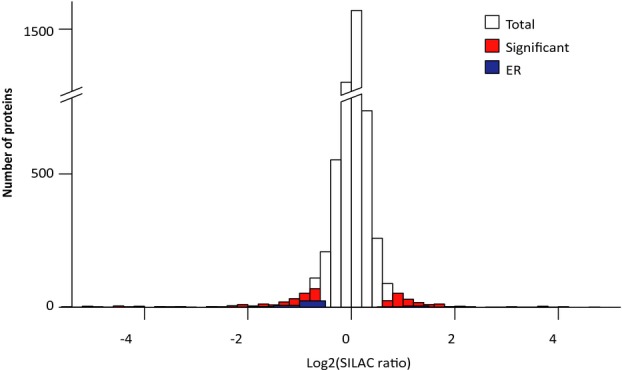
Differential UPR activation between two patients carrying the W1282X stop mutation in the CFTR gene.SILAC-based quantitative proteomic analysis of lymphoblastoid cell lines. A histogram of overall protein ratios shows high similarity between the patient-derived cells, with only 440 showing statistically significant differences (Significance < 0.05; Significant). Significantly different ER resident proteins (ER) are higher in the responsive CF patient.